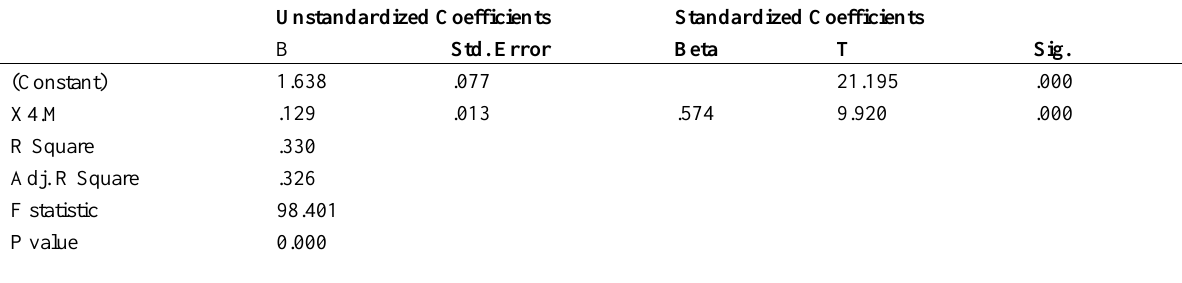
Table 3: Regression Model with